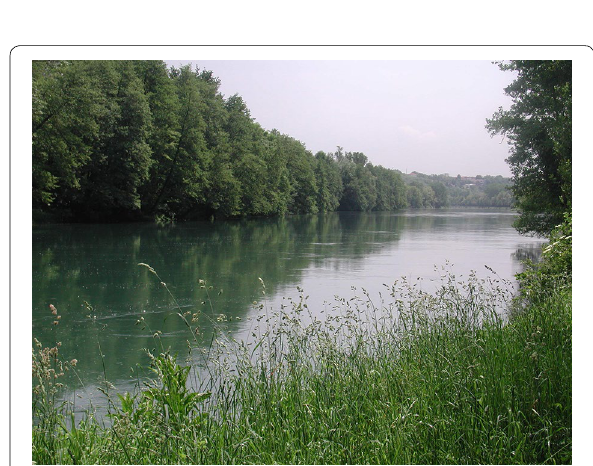
Fig. 5 Failure of intergenerational equity. The stretch of the river Adda, where it should rise the Bertonico hydroelectric plant. The plant has been challenged because the impact on the affected area, would produce the risk of raising the water table in an area that